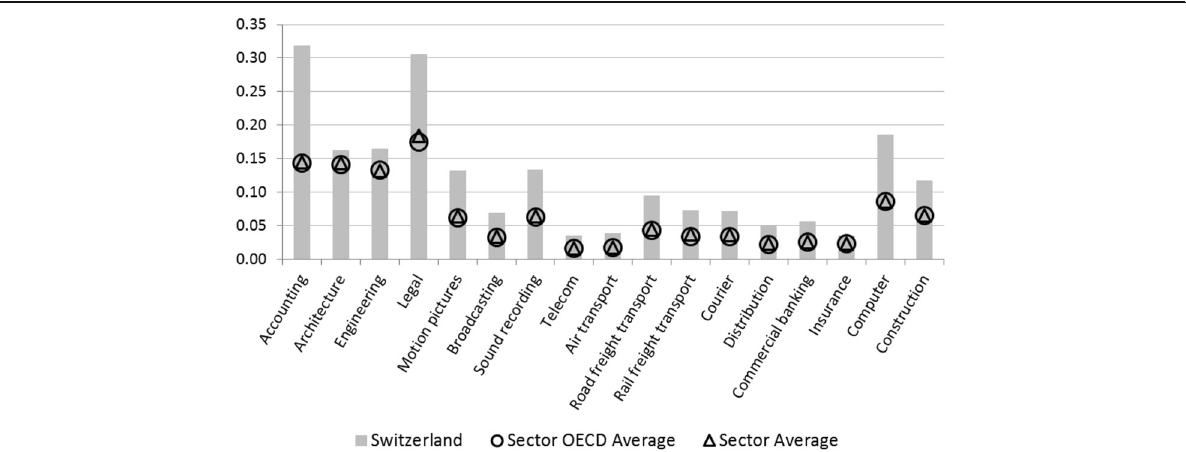
Fig. 14 Restrictions to movement of people in the Services Trade Restrictiveness Index for Swiss service sectors. Source: OECD